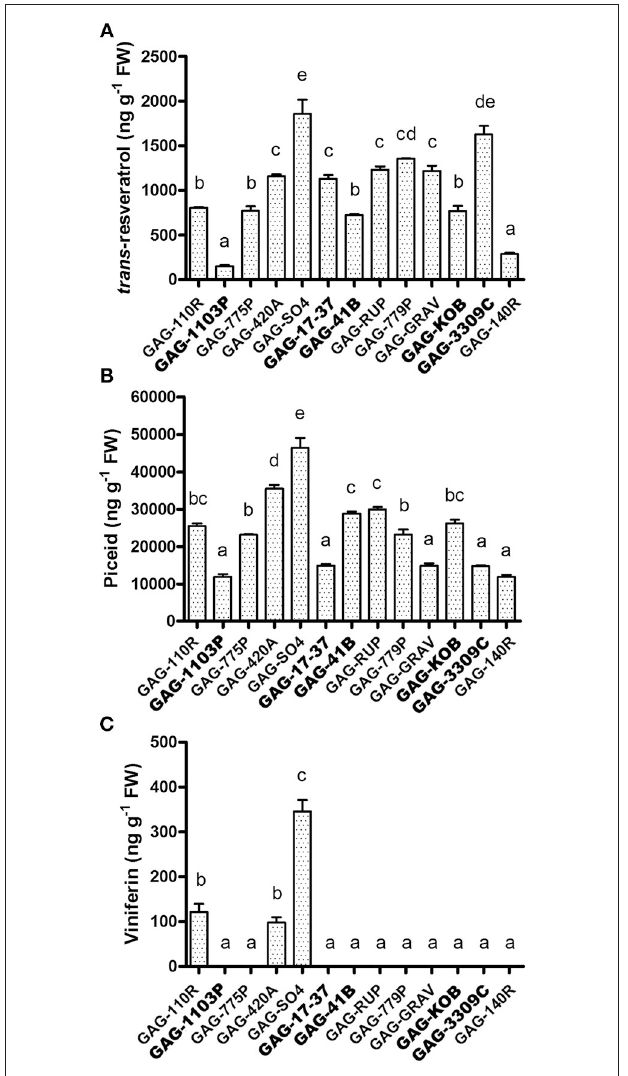
FIGURE 5 | Analysis of stilbenic compounds in scion leaves of 13 graft combinations. Quantification of trans -resveratrol (A) , piceid (B) and viniferin (C) assessed in the scion leaves. Lower case letters above bars denote significant differences by Tukey’s HSD-test ( P < 0.05). Data are expressed as mean ± SD ( n = 3). The combinations chosen for RNA-seq analyses are indicated in bold font.